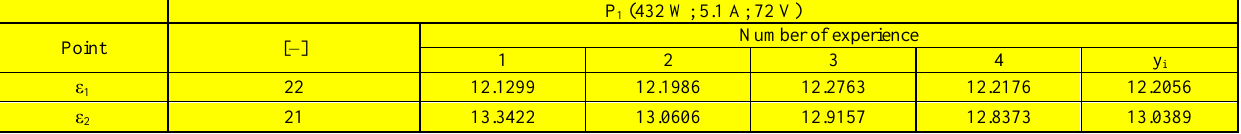
Table 3a. Value (average within one working cycle) of exhaust gas enthalpy h śr for variable values of compression ratio in point P 1